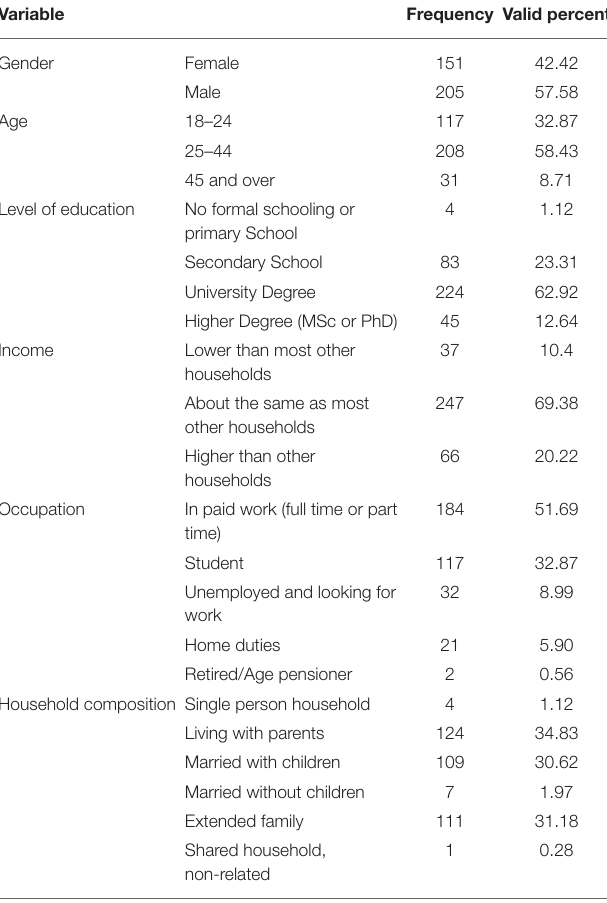
TABLE 1 | Socio-demographic characteristics of the study participants ( n = 356).